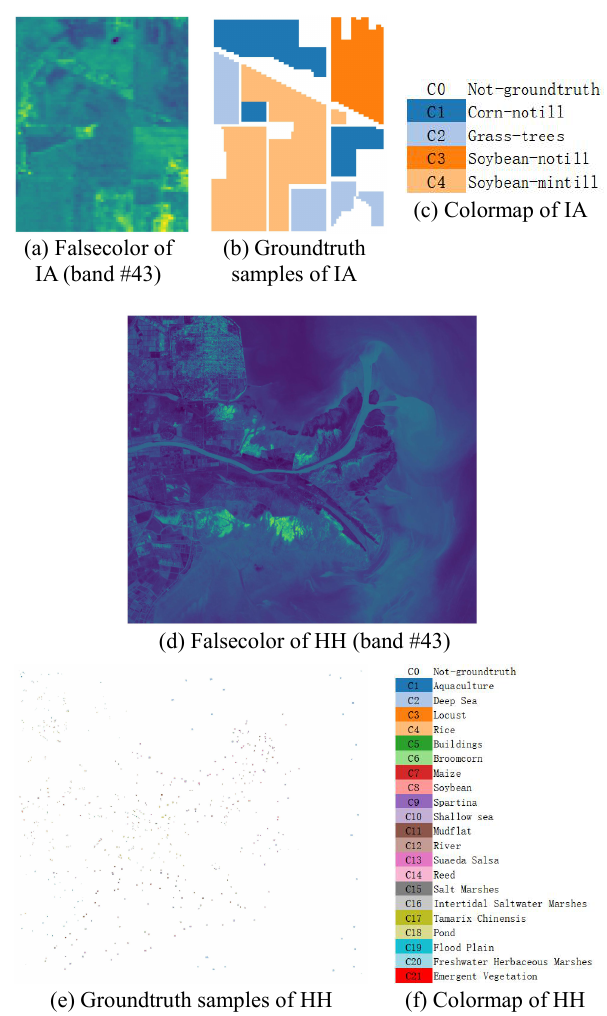
Figure 5 . Indian Pines-A (IA) and Huanghekou (HH) data